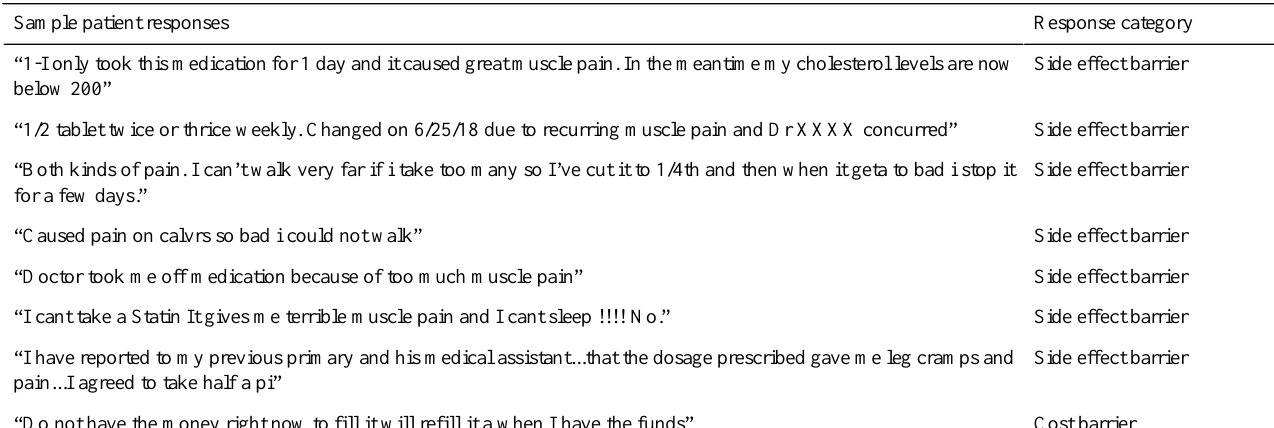
Table 7. Examples of unstructured patient messages when the conversational artificial intelligence successfully understood the